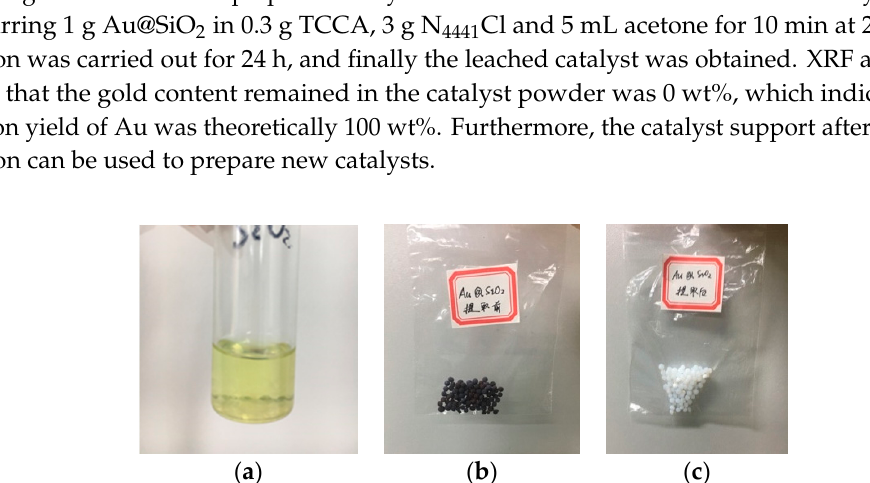
Table S1: The XRF of gold ores, Table S2: The XRF of Au@SiO 2 : ( a ) before leaching; ( b ) after leaching, Figure S1: ( a ) The dissolution rate curve of Au by TCCA / N 4441 Cl at 25 ◦ C; ( b ) fitting diagram of kinetic model (x = leaching yield of